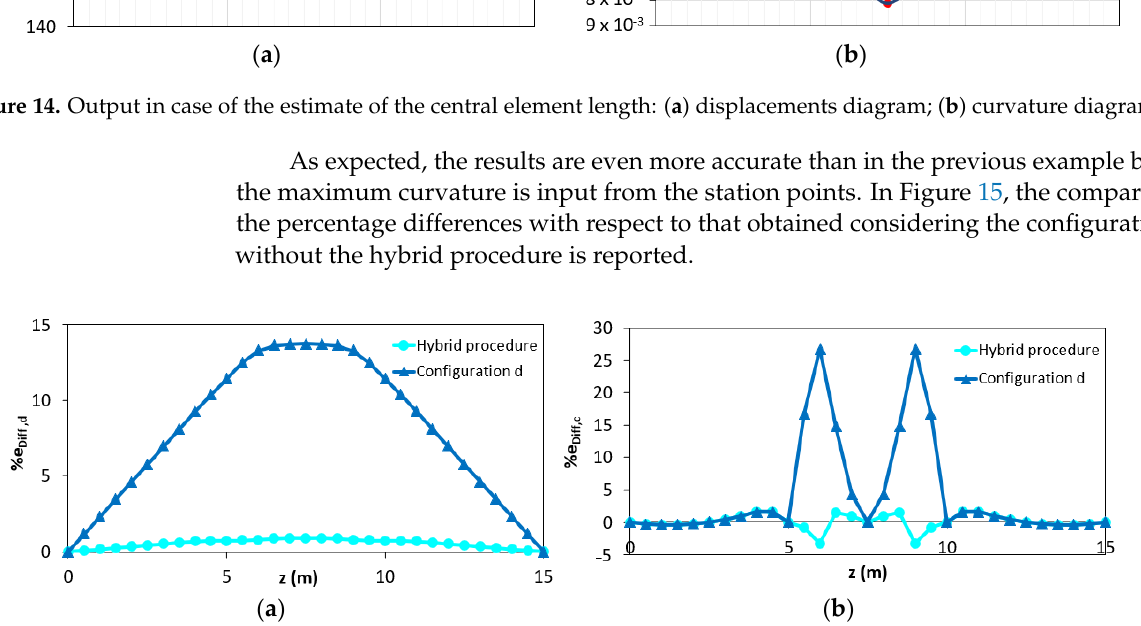
Figure 15. Distribution of the percentage difference in case of the hybrid procedure (blue curves) and without hybrid